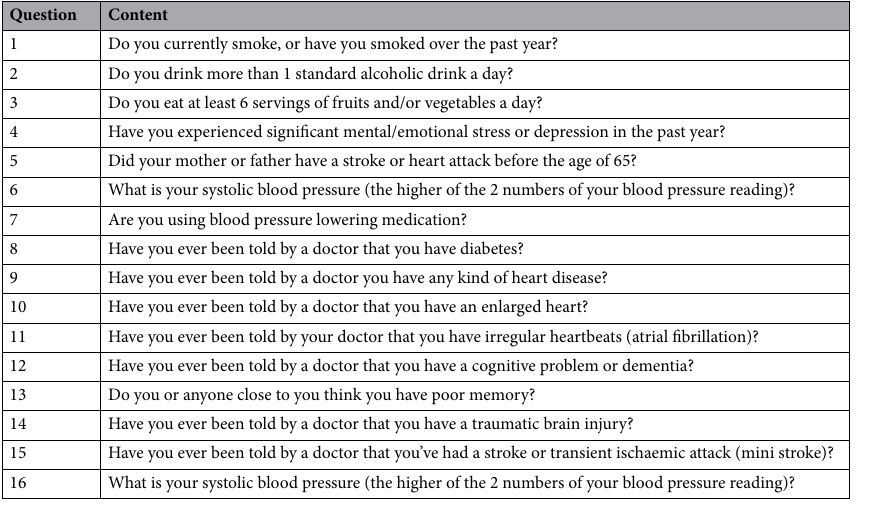
Table 4. Sixteen stroke riskometer questions used in